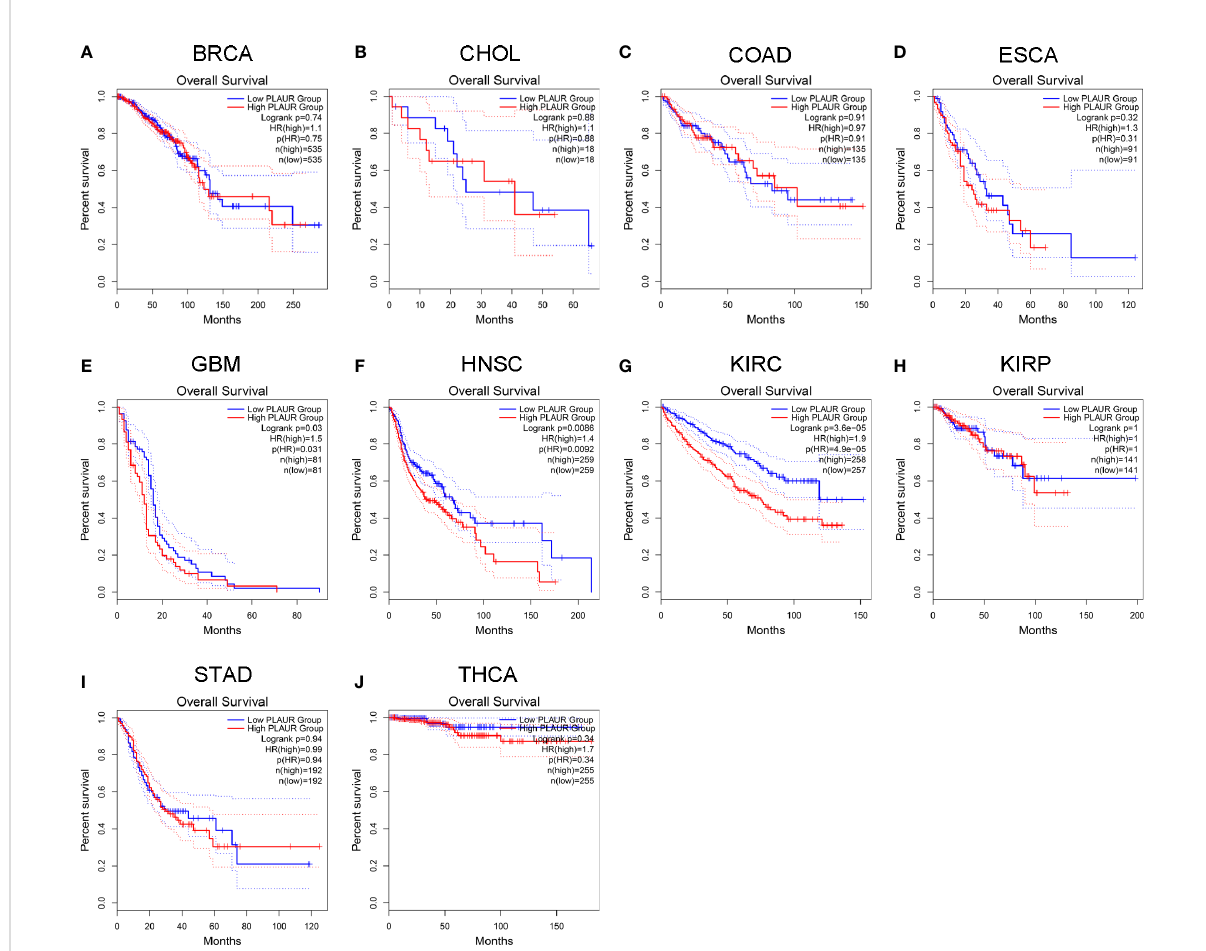
FIGURE 2 Kaplan-Meier survival curve for OS in 10 different tumor types using the GEPIA database. (A – J) BRCA, CHOL, COAD, ESCA, GBM, HNSC, KIRC, KIRP, STAD,